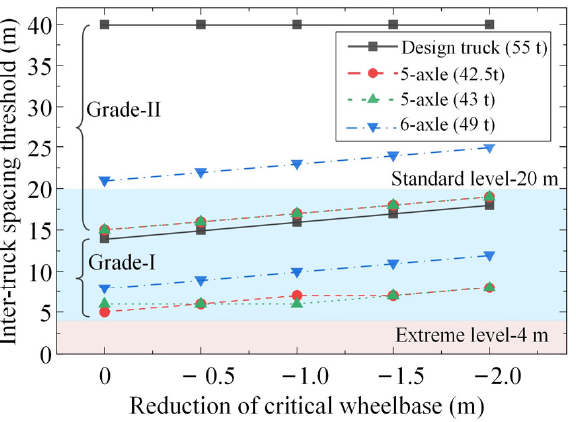
Figure 9. Inter-truck spacing thresholds for ATP crossing simply supported bridges with different reductions in the critical wheelbase (identified based on the shear force under the action of two-truck ATP with full loads).